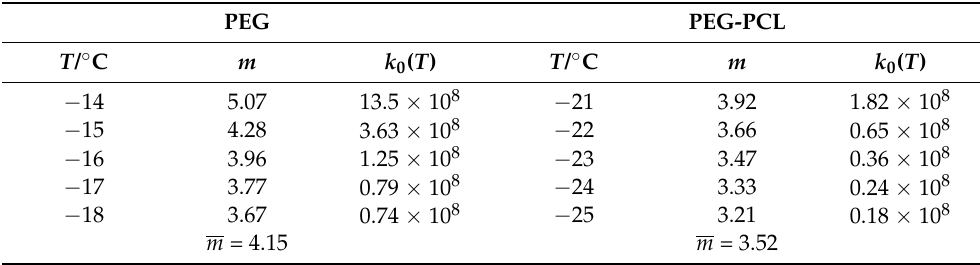
Table 2. Ozawa parameters of PEG and PEG-PCL at different temperatures.